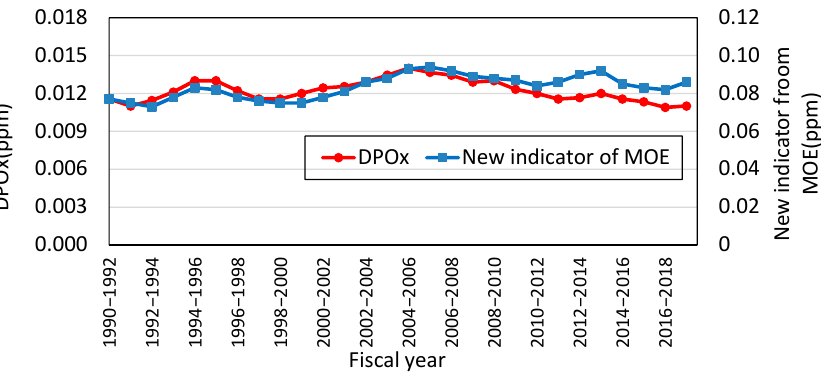
Figure 32. Trend in DPOx with the new indicator from the MOE. DPOx: same as Figure 31. New indicator from the MOE: same as Figure 8.